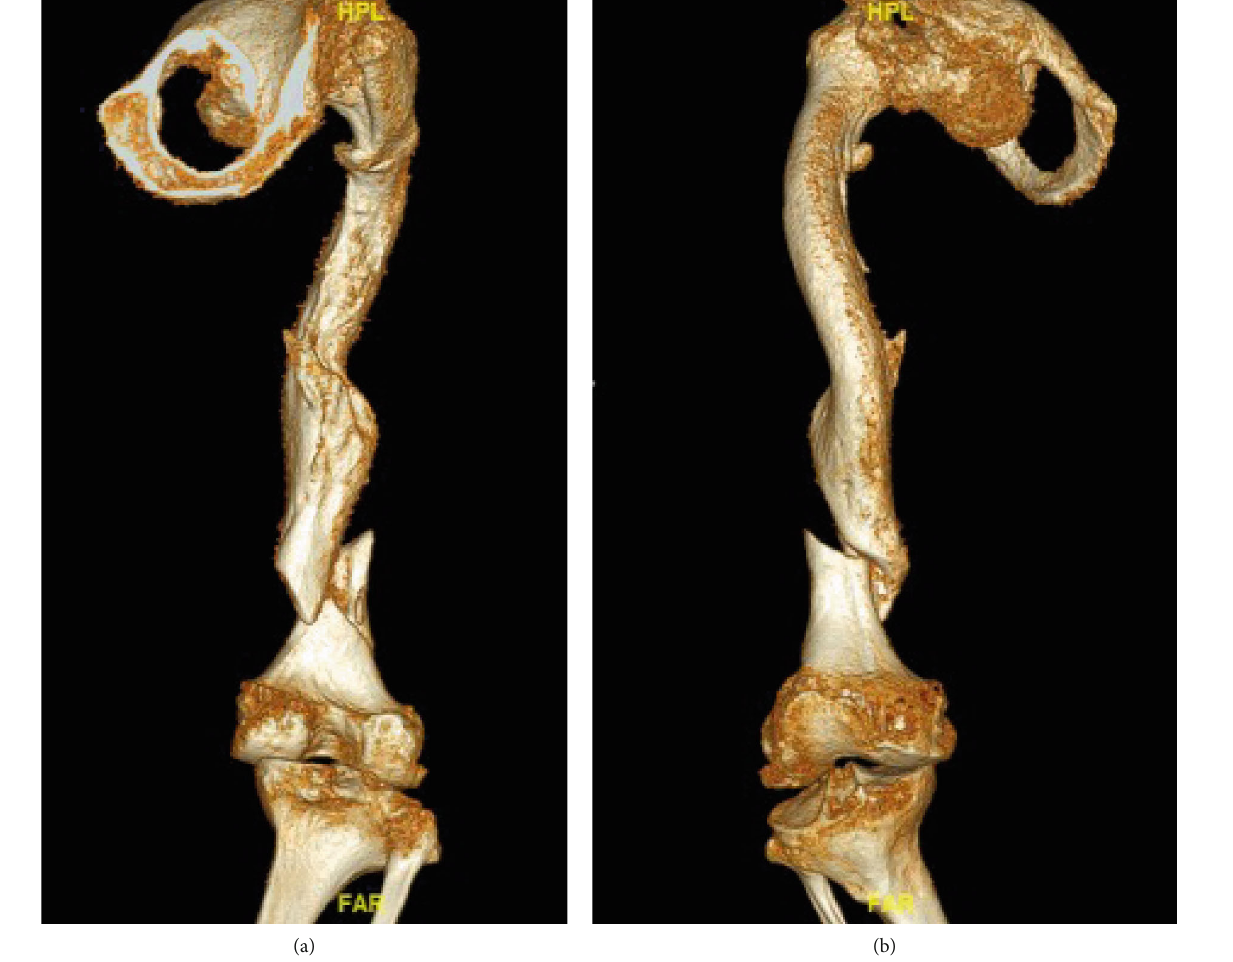
Figure 1: 3D computed tomography of the right femur after admission to our emergency department. The images show the fractured femur on the second day after an accident. (a) Femur from dorsal view, where the multifragment characteristic of the fracture can already be assumed. (b) Corresponding ventral view of the